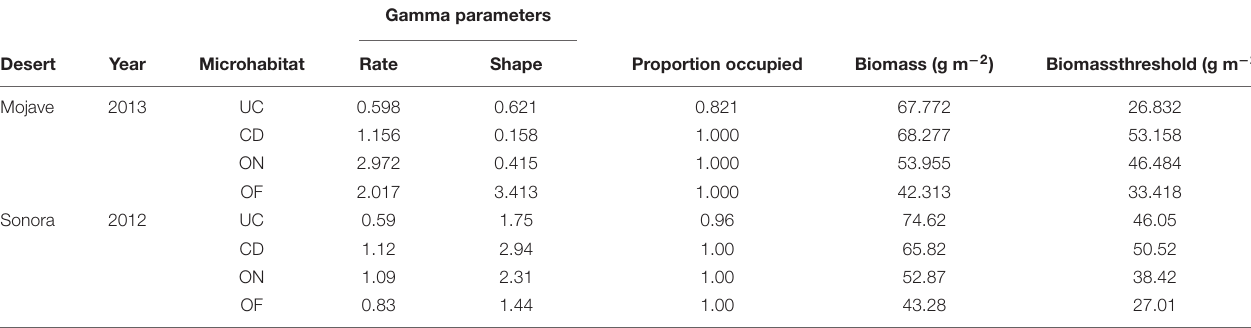
TABLE 3 | Biomass values fit to a gamma distribution from the experiment conducted in the Mojave and Sonoran deserts. Gamma